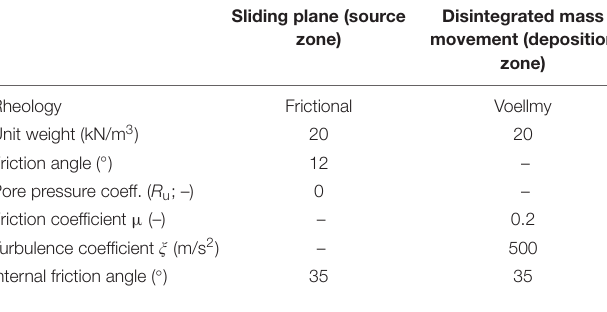
TABLE 4 | Properties of path-materials for the best-fit model